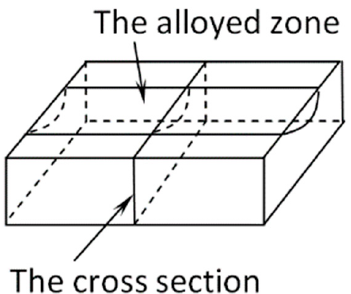
Figure 2. The calculated temperature ( a ) and the cooling rate ( b ) distribution in the distance from the surface to the core material (z) during the laser treatment with the applied laser beam parameters.